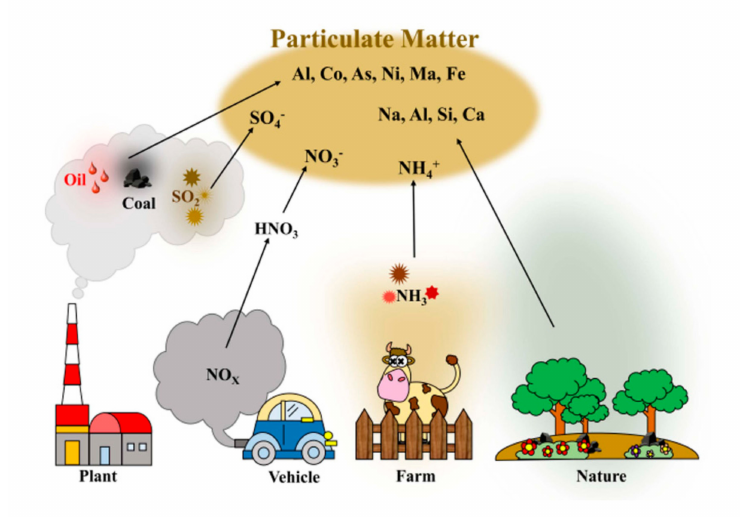
Figure 2. Schematic illustration for particulate matter (PM) generated from various